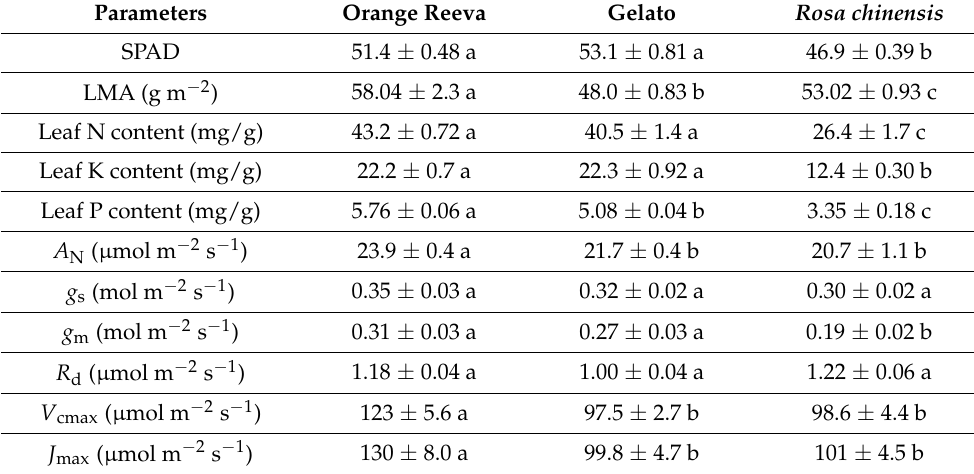
Table 1. Photosynthetic characteristics of three studied rose genotypes. Different letters at the end of values indicate significant difference among these three